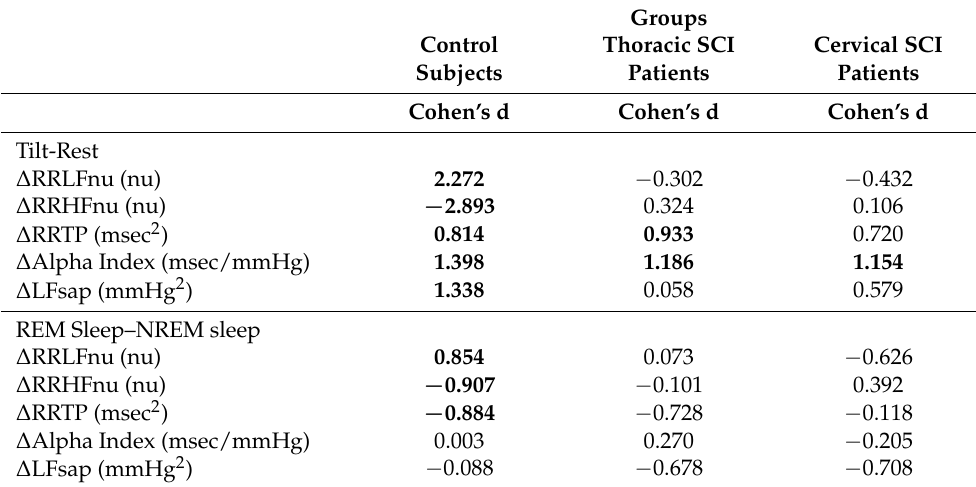
Table 3. Effect size of the changes in selected spectral analysis indices from Rest to Tilt and from NREM to REM sleep in the three study